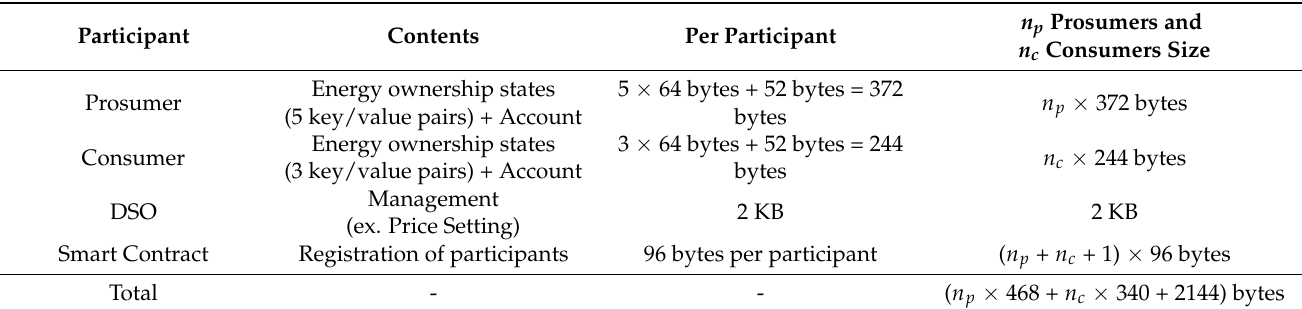
Table 11. Need storage as a function of